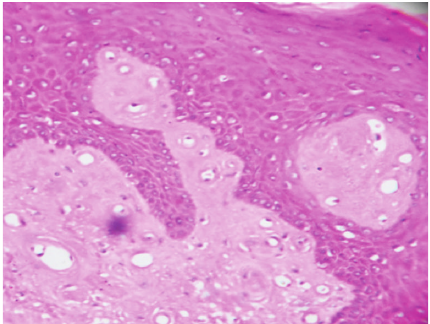
Figure 5: Hematoxylin and eosin stained sections (40x) revealed stratified squamous parakeratinized hyperplastic epithelium with presence of fibers, fibroblasts, blood vessels, and numerous eosinophilic amorphous aggregates in the connective